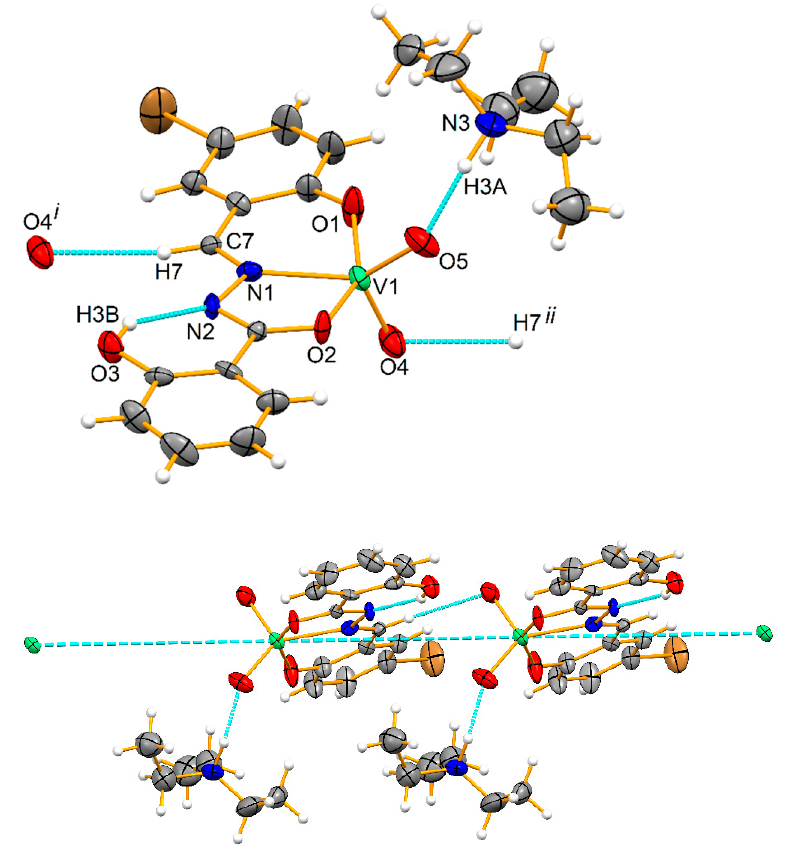
Figure 2. Ellipsoid plot of 2 (drawn at 30% probability level) with partial atom numbering scheme ( top ) and a fragment of the molecules alignment along the b axis ( bottom ). Only one component of the disordered triethylammonium cation is represented. Selected bond distances (Å) and angles (°):